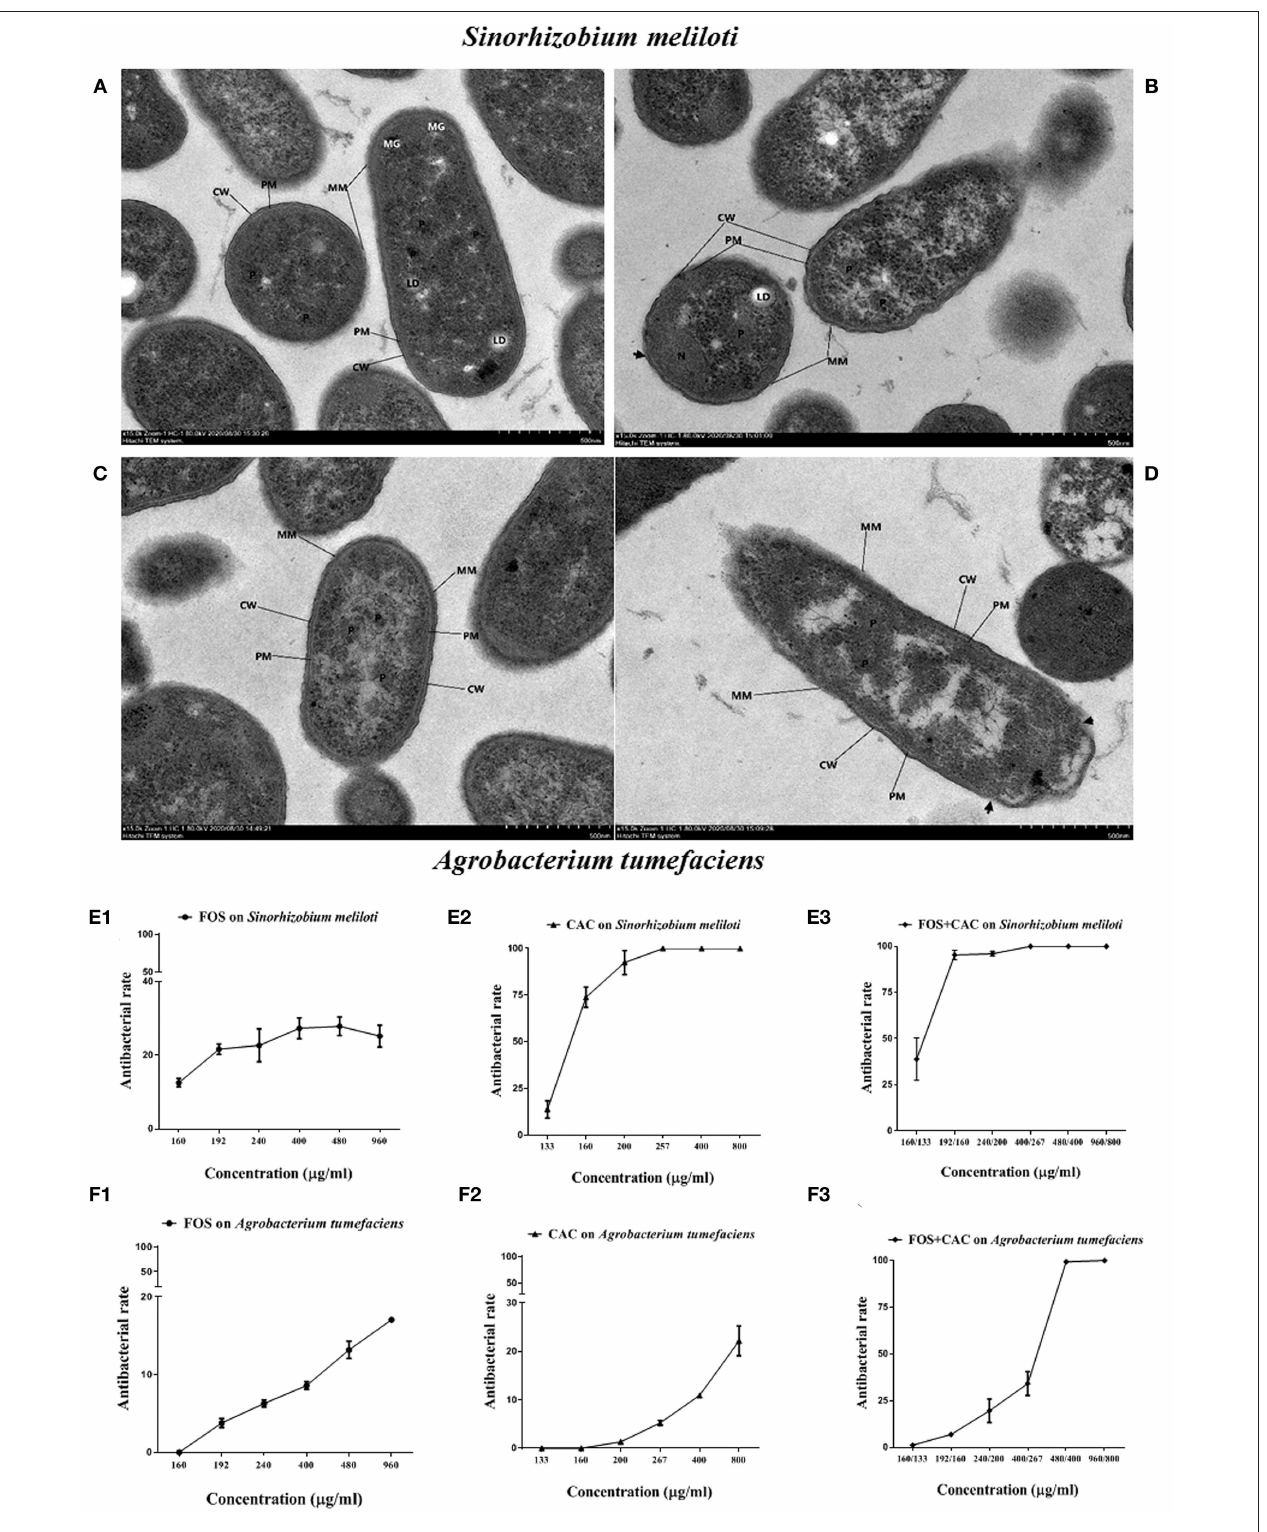
FIGURE 4 | TEM images and antibacterial rate on two substitute bacteria of Ca .Las with FOS or/and CAC. (A) Control image of Sinorhizobium meliloti . (B) TEM image of Sinorhizobium meliloti with FOS + CAC (400/267 µ g/mL) treatment. (C) Control image of Agrobacterium tumefaciens ; the cell membrane (PM) is intact, no obvious plasmolysis and membrane breakage and dissolution are seen, and the periplasmic interval is normal. (D) TEM image of Agrobacterium tumefaciens with